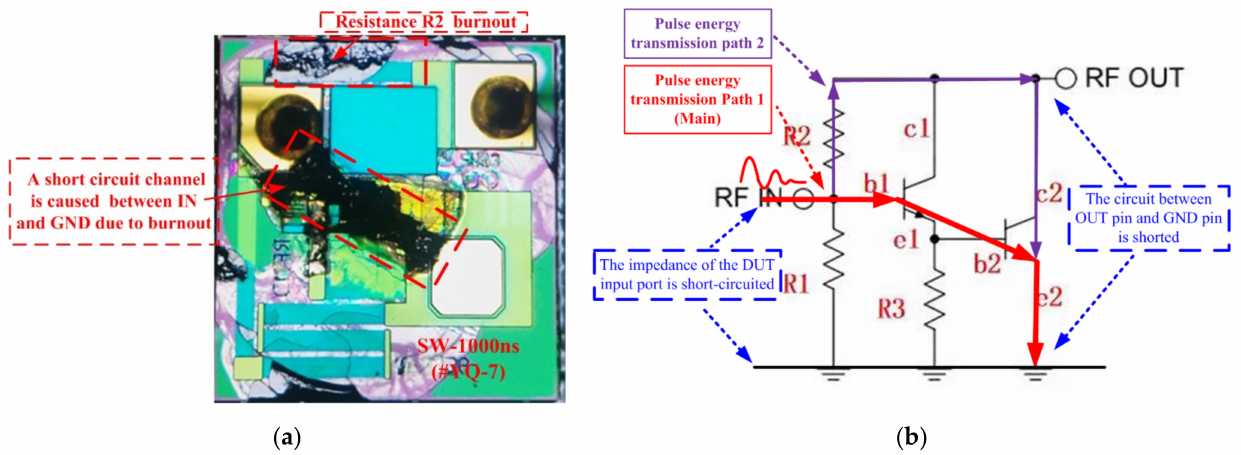
Figure 11. Effect mechanism analysis: ( a ) explanation for burnout effect of Sample #YQ-7; ( b ) Pulse transmission